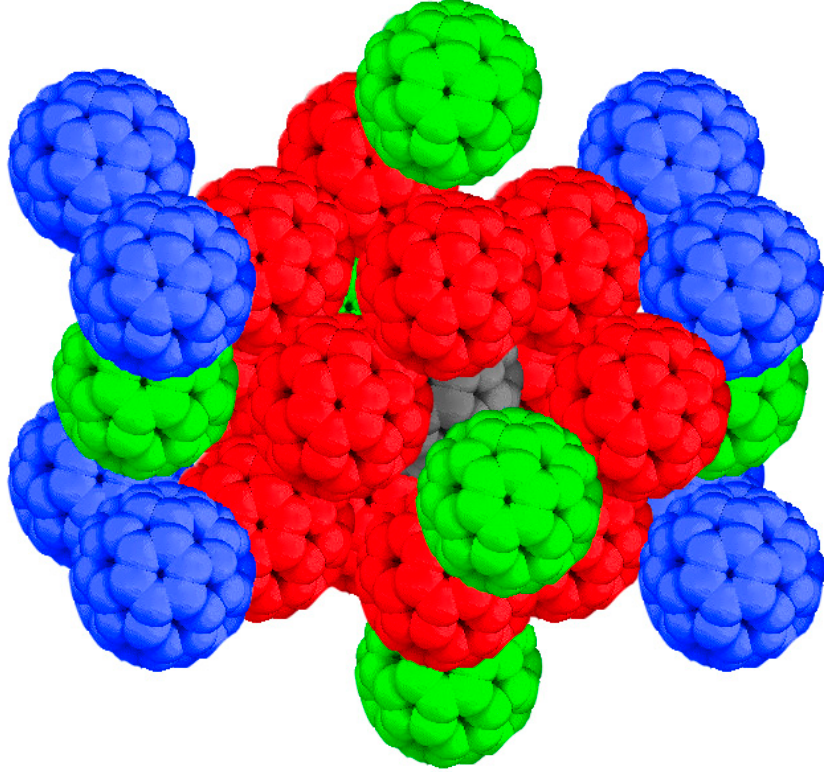
Figure 2. Minimal fragment of FCC lattice of plastic fullerite consisting of 27 fullerenes. Grey: central fullerene; red, fullerenes of first environment echelon (12 pieces); green, second echelon molecules (6 pieces); blue, third echelon molecules (8 pieces).